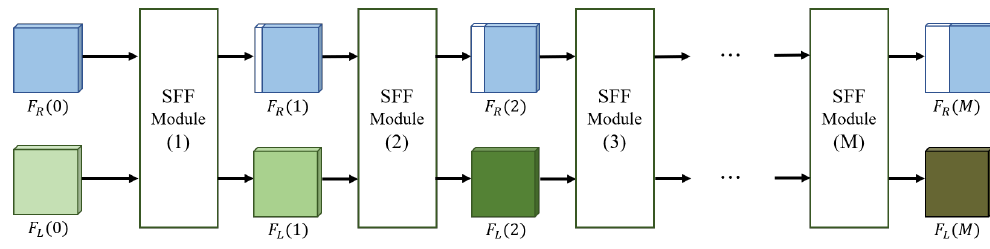
Figure 2. Connections between SFF modules in the